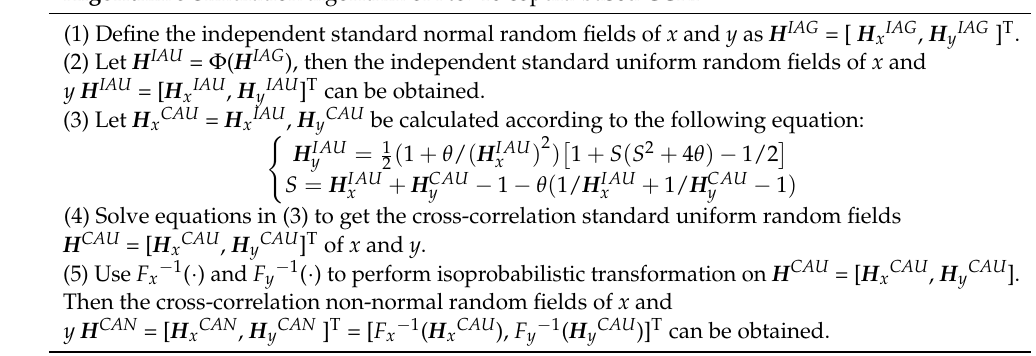
Algorithm 5 Simulation algorithm of No. 16 copula-based